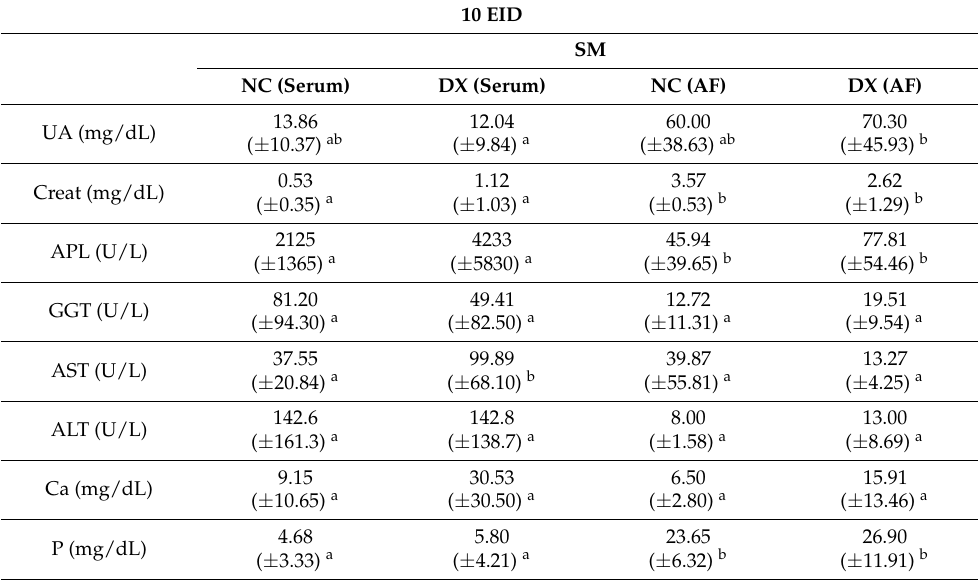
Table 8. Quantification of metabolites, minerals and enzymes in serum and AF in CE treated with FG and DX at 10EID inoculated via